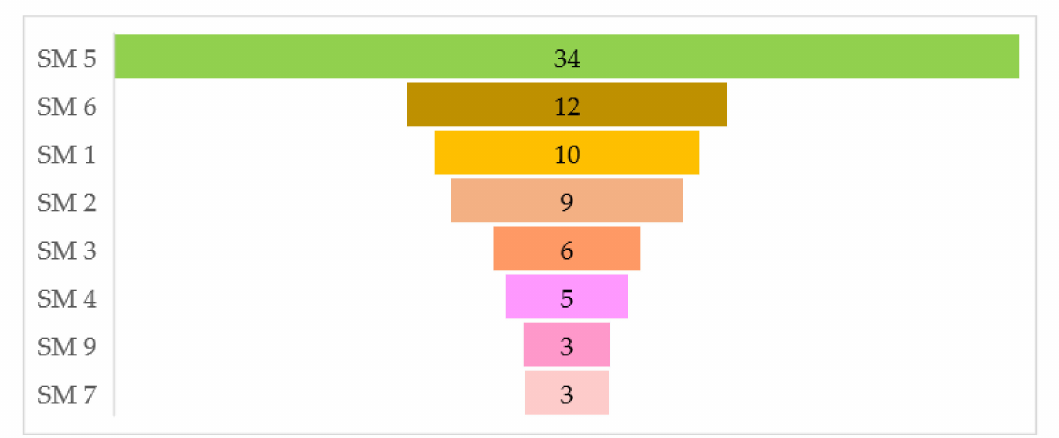
Figure 4. The relative influence of different strategic measures on the construction of mega-projects on